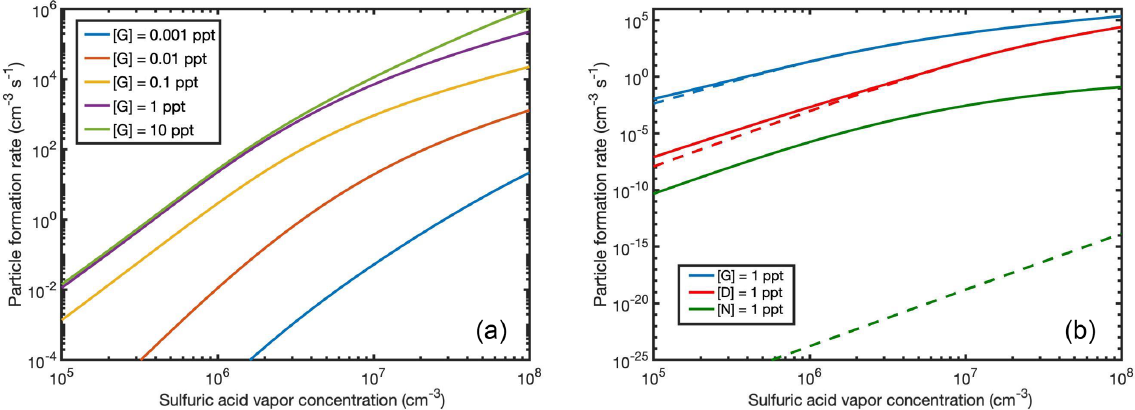
Figure 10. Particle formation rates from sulfuric acid and guanidine at [guanidine] = 0.001–10ppt V in the presence of ions (a) , and ion- mediated (solid line) and neutral (dashed line) particle formation rates for guanidine, dimethylamine and ammonia at base concentrations of 1ppt V (b) as a function of sulfuric acid vapor